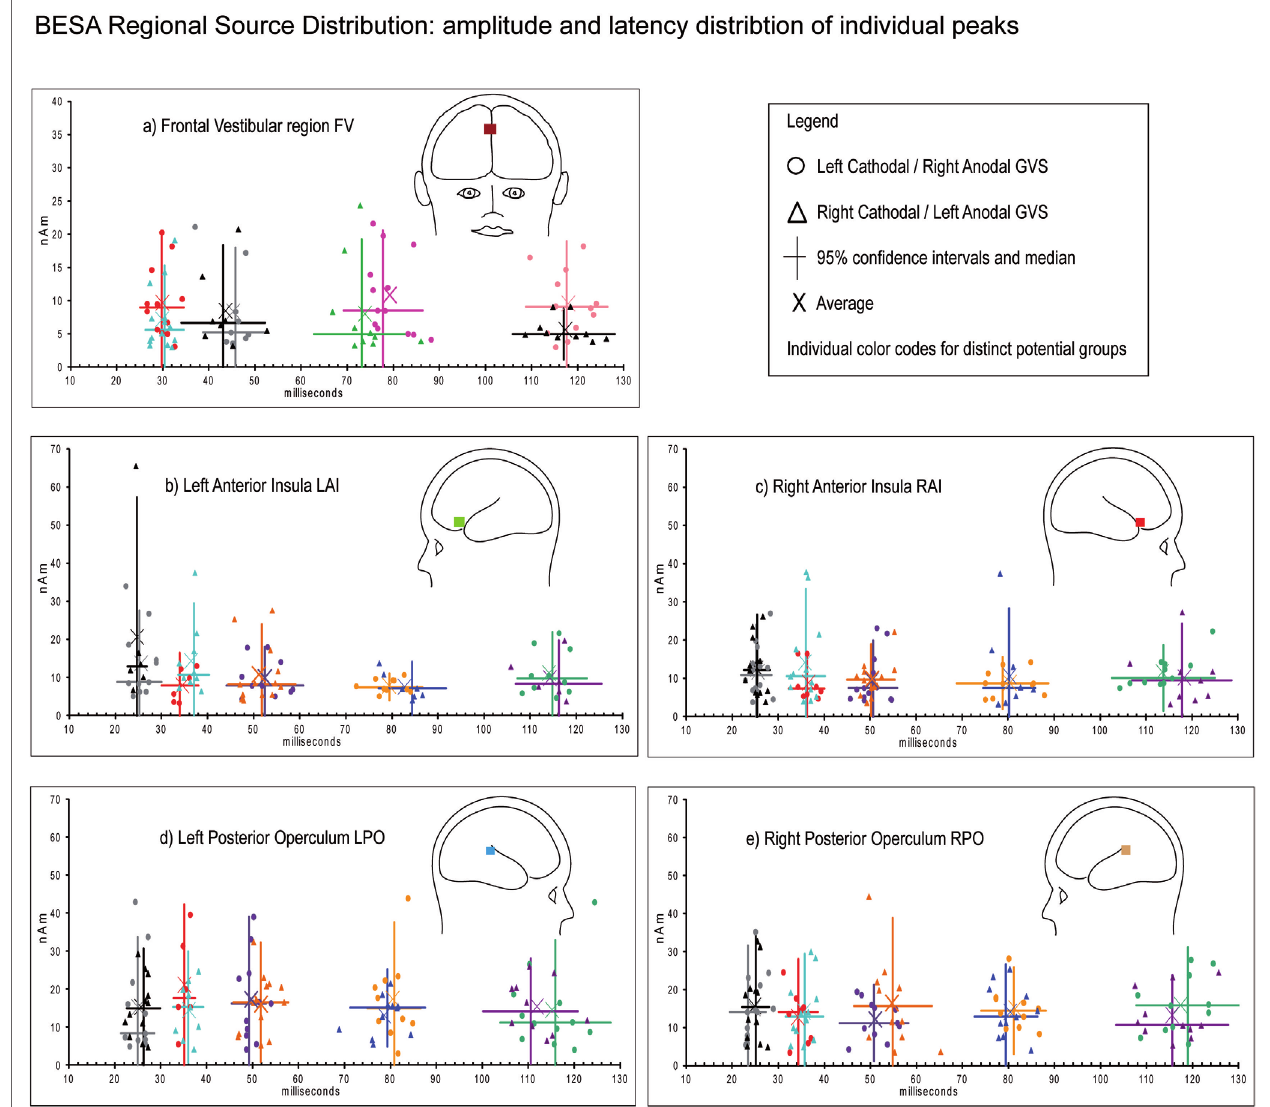
FigUre 2 | Galvanic vestibular-evoked potentials in the five investigated cortical regions FV (a) , right anterior insula (RAI) (B) , left anterior insula (LAI) (c) , right posterior operculum (RPO) (D) , and left posterior operculum (LPO) (e) with the individual subjects’ potential latencies and amplitudes for left cathodal stimulation (circles) and right stimulation (triangles) with individual colors to distinguish potential clusters at 25, 35, 50, 80, and 110 ms in RAI, LAI, RPO, and LPO and 30, 45, 70, and 110 ms in frontal regions FV. The potential latencies were significantly different from one another within one region ( Table 2 ), whereas no explicit effects were found for side of stimulation on either amplitude or latency or between cortical regions of